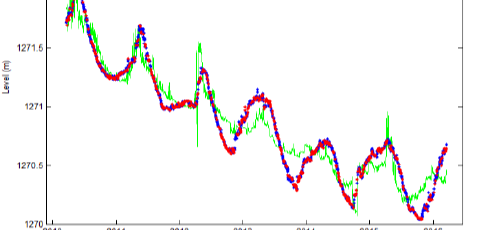
Figure 7: Discharge of changes over the period of 2010-2016